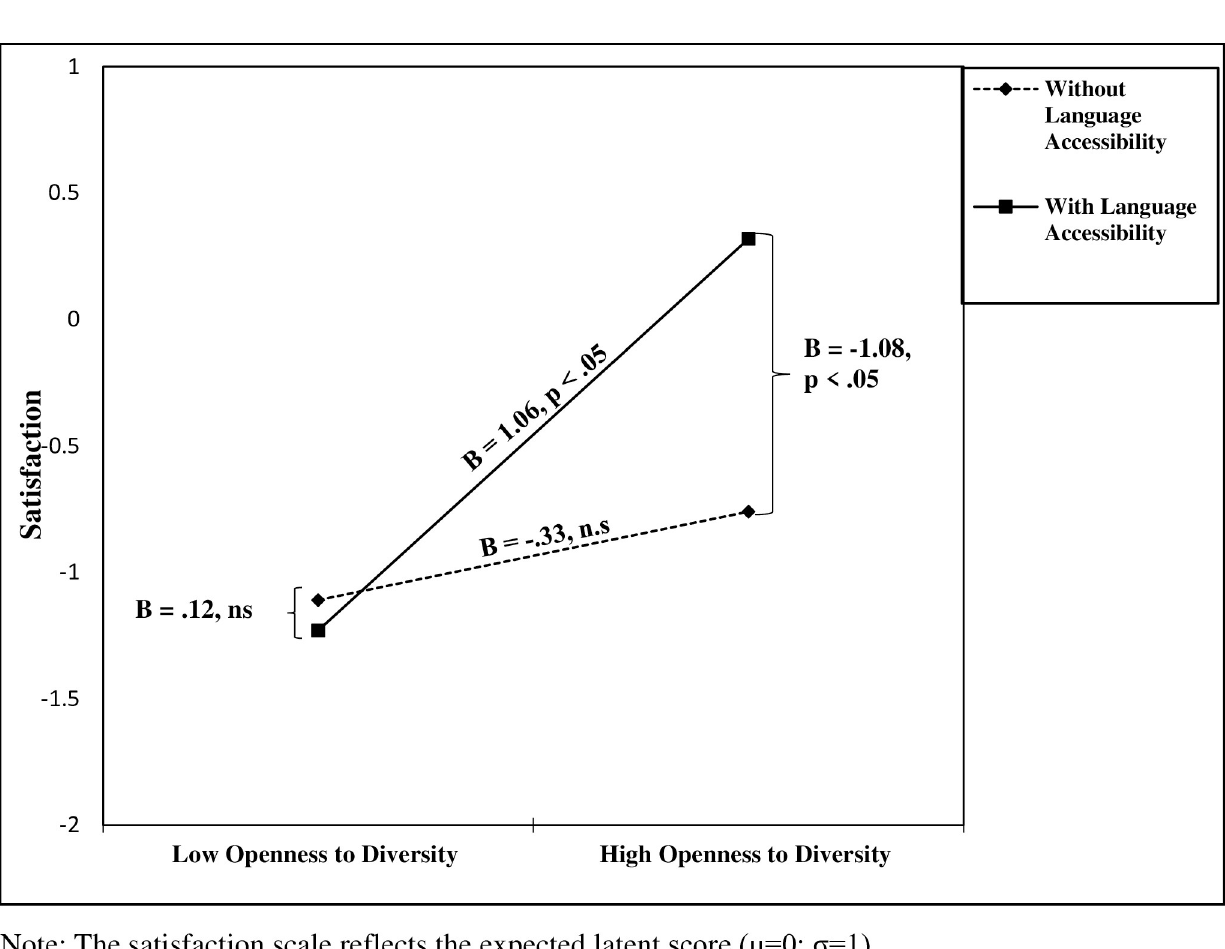
Fig 2. Interaction of care receivers’ openness to diversity and language accessibility on care receivers’ satisfaction for a cultural minority group (Israeli Arabs).